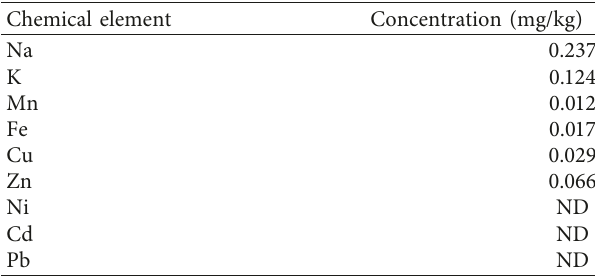
Table 5: Concentration of metals found in the Amazon sailfin catfish